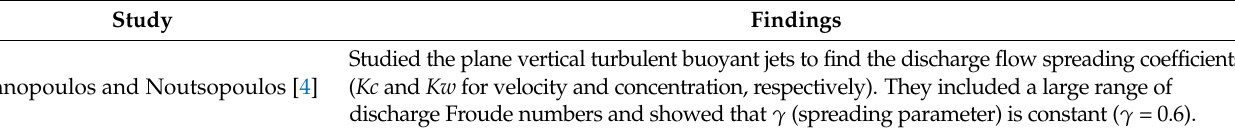
Table 1. Previous studies of vertical dense discharges in deep waters.